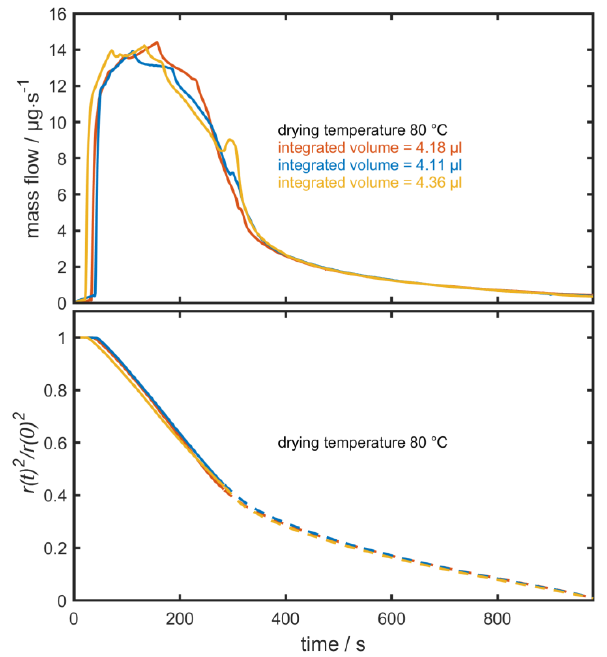
Figure 7. Top : Measured H 2 O mass flow of three levitated 10 wt% lysozyme solution droplets at the same drying temperature of 80 °C and a nitrogen flow rate of 1.0 nl/min; the dashed lines do not show the real physical behavior of the droplet radius after the critical point of drying, but are only given for completeness. Bottom : Calculated normalized squared equivalent radius of the evaporating protein solution droplets at the same drying temperature of 80 °C.